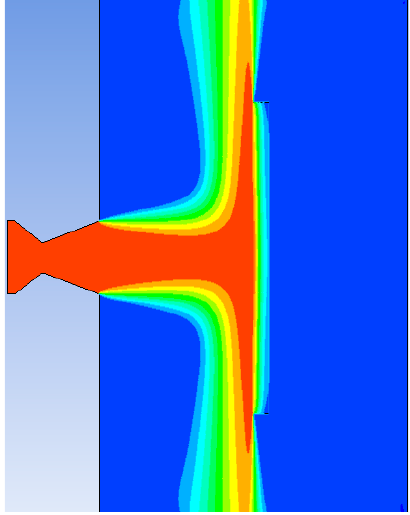
Figure 10. The temperature distribution of heat flow.